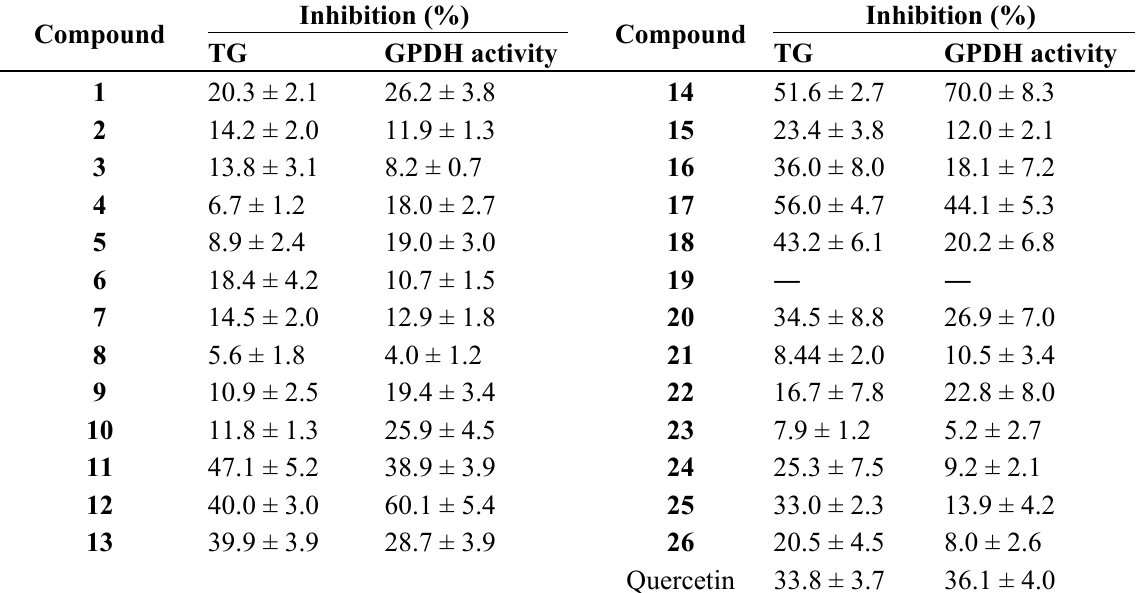
Table 2. Inhibition of TG Content and GPDH Activity by the isolated compounds in 3T3-L1